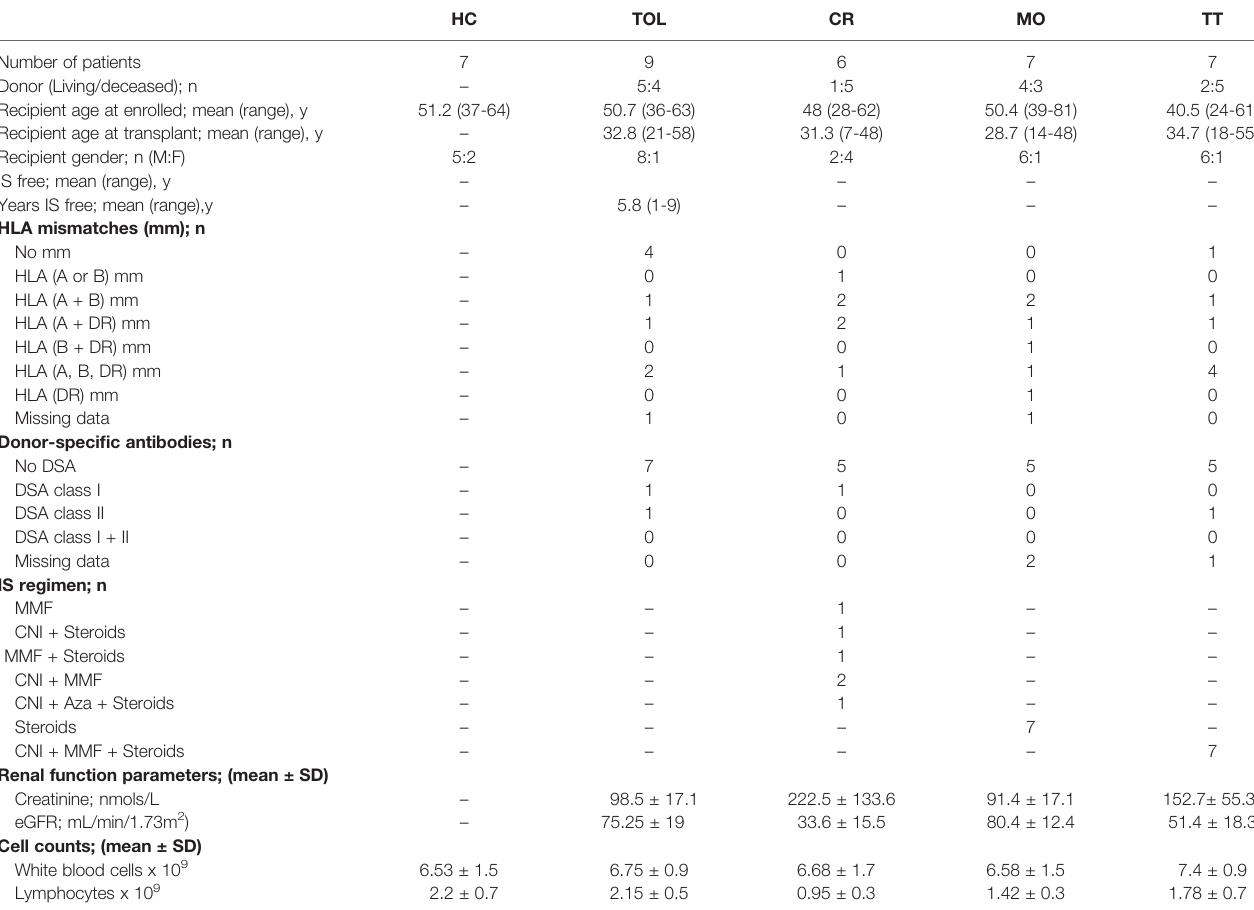
TABLE 1 | Clinical data of KTR groups and healthy